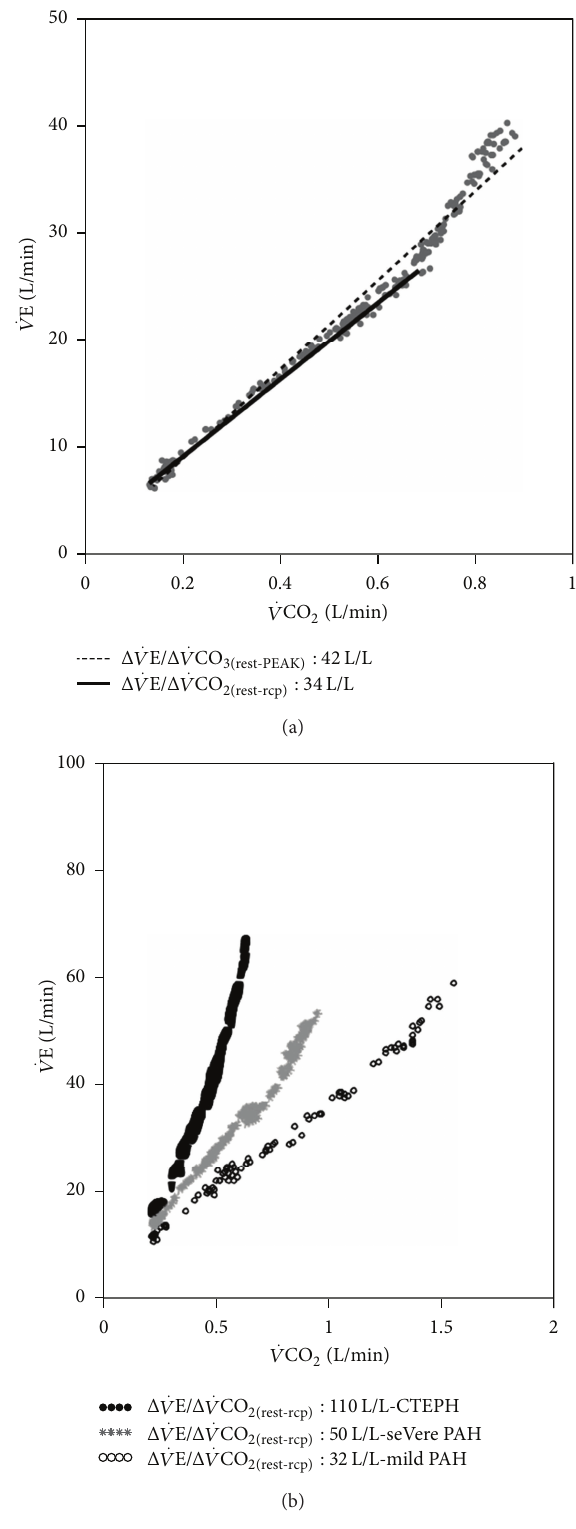
̇𝑉 )/ carbon dioxide output ( ̇𝑉 Figure 7: (a) Minute ventilation ( E compensation point (solid line) or up to peak exercise (dashed line) in a patient with CHF. Note that Δ Δ ̇𝑉 /Δ ̇𝑉 because it adds a component of hyperventilation to lactic acidosis and/or other stimuli after the respiratory compensation E CO 2( rest-RCP ) ̇𝑉 /Δ ̇𝑉 point. (b) Δ as a function of disease severity in pulmonary arterial hypertension (PAH). Higher values, however, are usually found E CO 2 in chronic thromboembolic pulmonary hypertension (CTEPH) due to pronounced increases in tidal volume